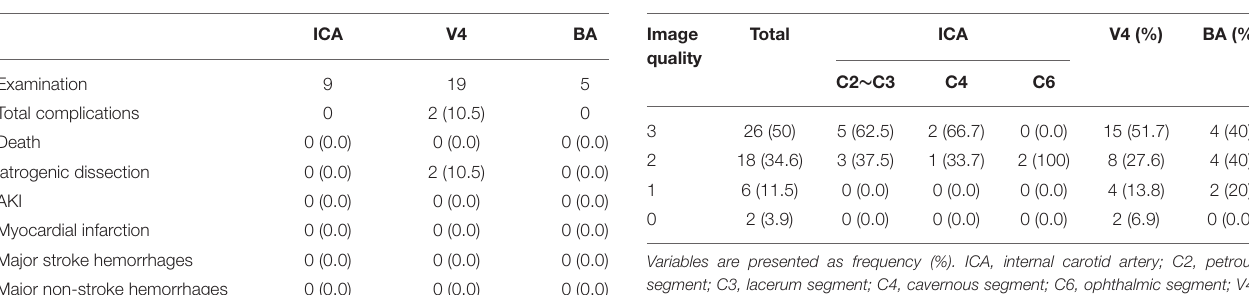
TABLE 2 | Procedural complications. TABLE 3 | Image quality of optical coherence